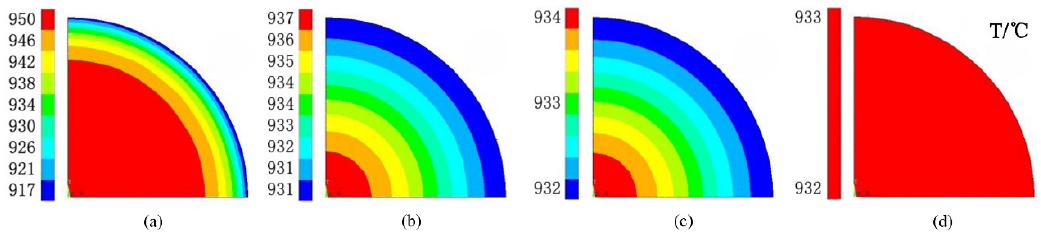
Figure 3. Temperature distribution contour at different time in the graphite mould (a) 0.1s, (b) 2.5s, (c) 4.5s, (d)5s.